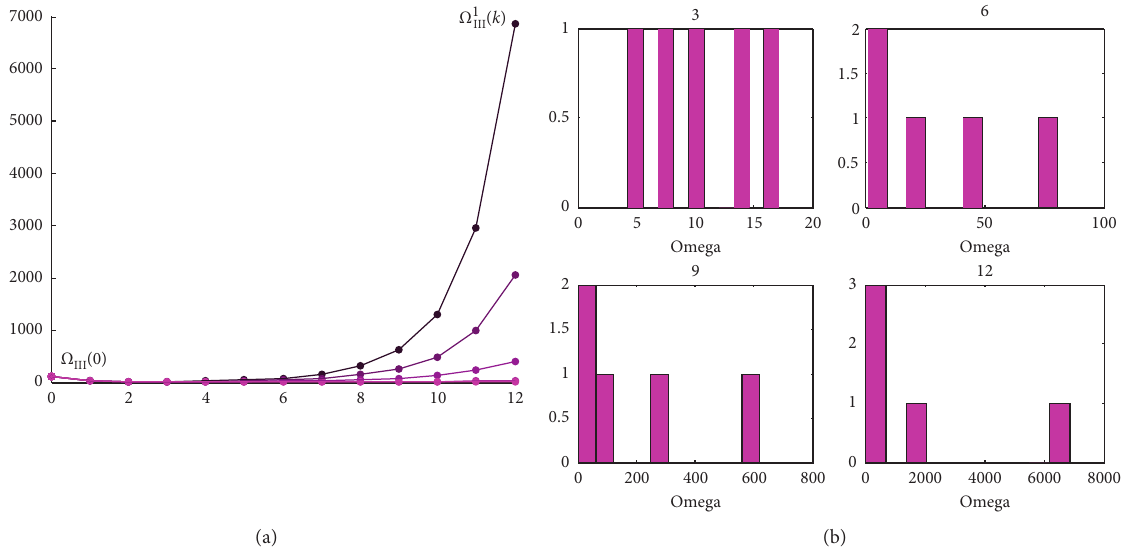
Figure 4: Behavior of Ω ( k ) for a period of three, six, nine, and twelve months for an initial condition of violence Ω III (a) Ω n ( k ) for twelve months k � 12; (b) distribution of probable values of Ω n